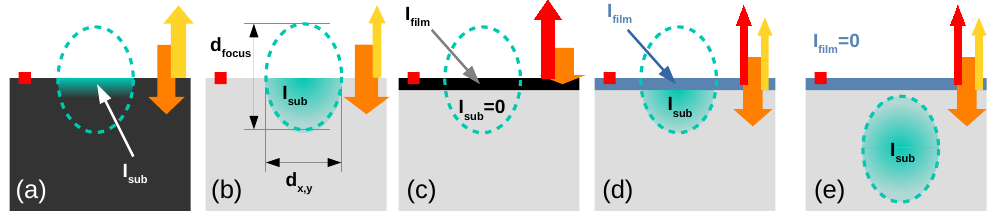
Figure 2. Schematics of the sample volume, where the Raman signal is originated, as well as reflectance losses in a Raman microscope. The dashed ellipsoid indicates the asymmetric focal point of lateral width d x,y and depth distribution d focus . The green, shaded areas indicate the volume generating the substrate Raman signal I sub . ( a ) depicts a bulk absorbing substrate; ( b ) a transparent substrate; ( c ) an absorbing thin film, where no substrate signal occurs; ( d ) a thin film on transparent substrate, creating signal from the film I film and substrate I sub ; and ( e ) the same but with focus shifted into the sample and no film signal. The focal point in Raman spectroscopy is typically determined by focusing on small surface structures as indicated by the red box. The orange arrows depict the incident laser light transmitted into the substrate, yellow arrows the fraction reflected at the substrate surface and red arrows additional reflection by the thin